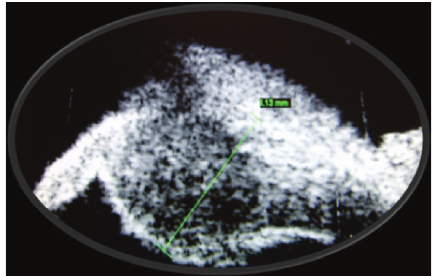
Figure 4: UBM picture showing partial resolution of the mass at 2 weeks.